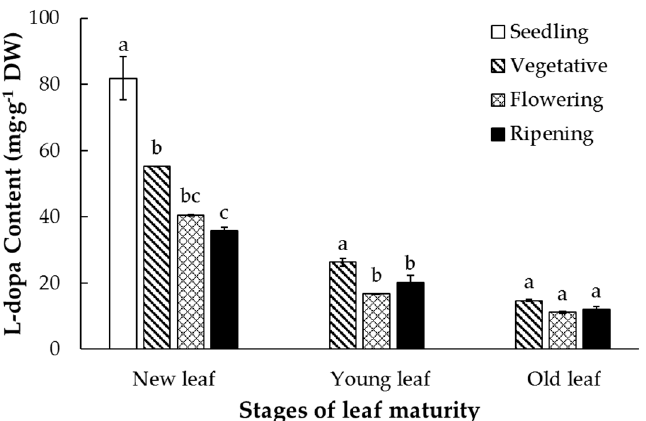
Figure 3. Changes in L-dopa content in leaves of faba plants at different stages of maturity. Different letters indicate significant differences at p < 0.05 (Tukey’s HSD test).